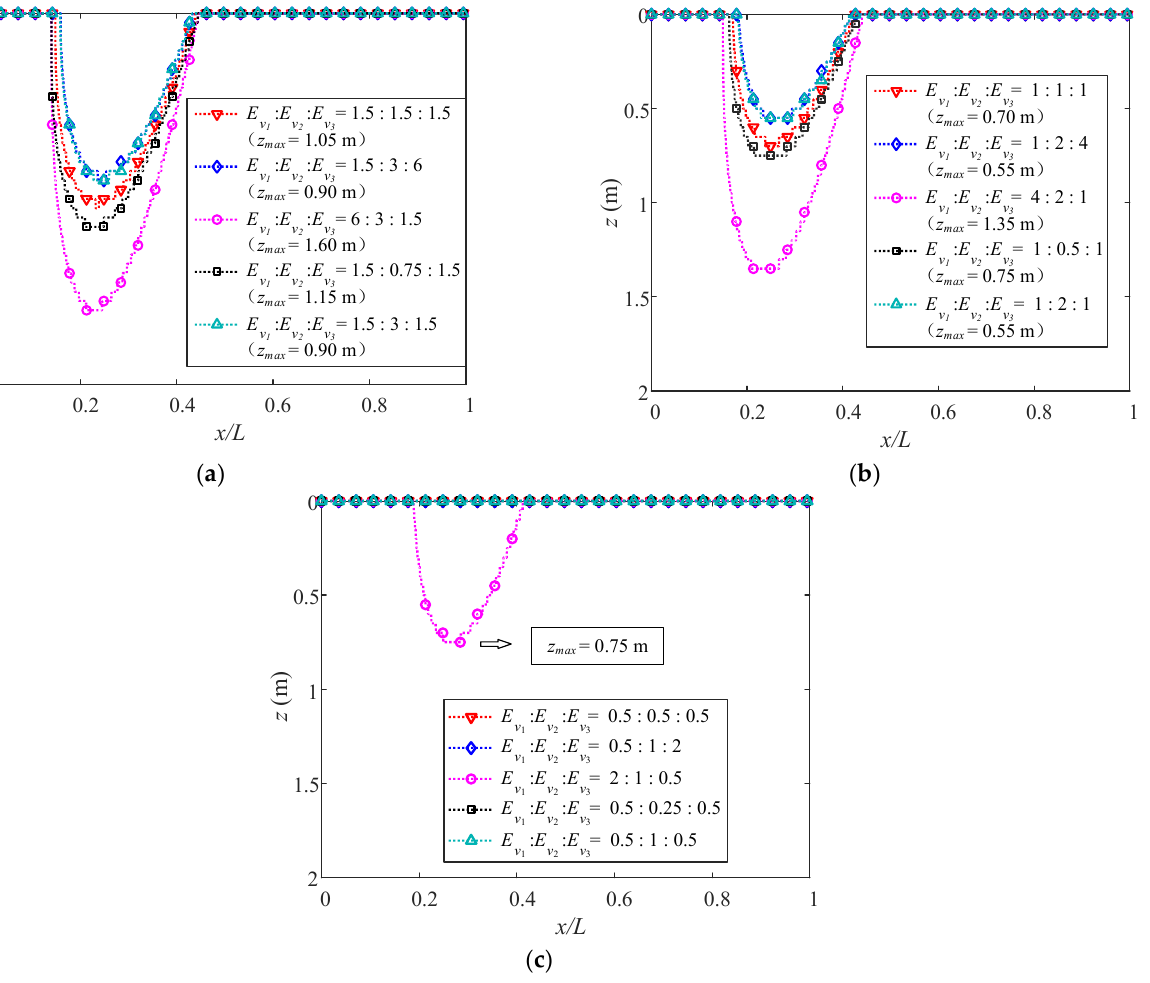
Figure 18. Liquefaction depth along wave propagation at t = 20 s with ( a ) E vo / E ho = 1.5, ( b ) E vo / E ho = 1 (isotropic), and ( c ) E vo / E ho = 0.5 ( o = 1, 2, 3).